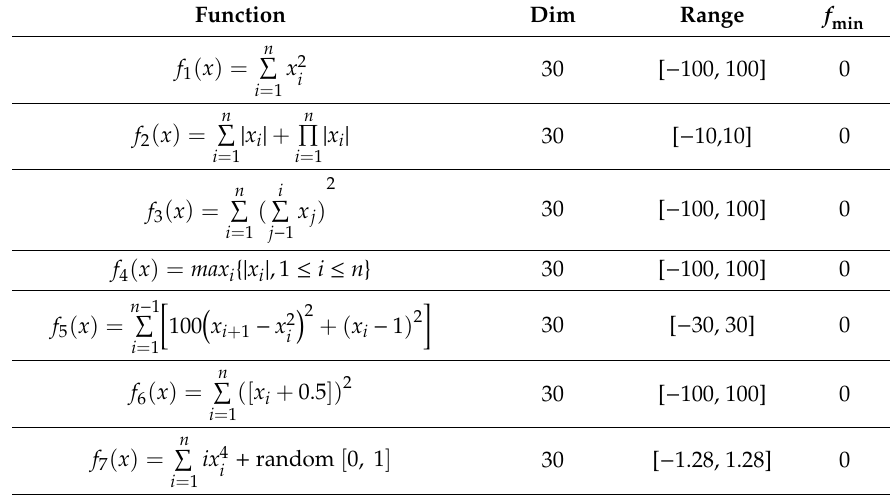
Table 1. Unimodal benchmark.